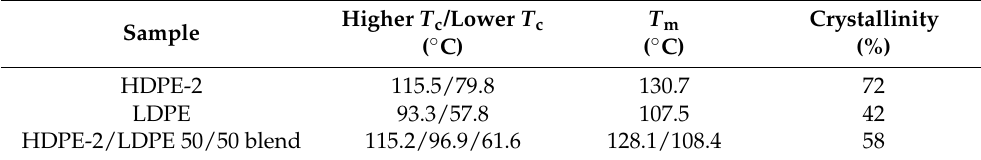
Table 4. DSC data of the HDPE-2/LDPE 50/50 blend compared with the neat